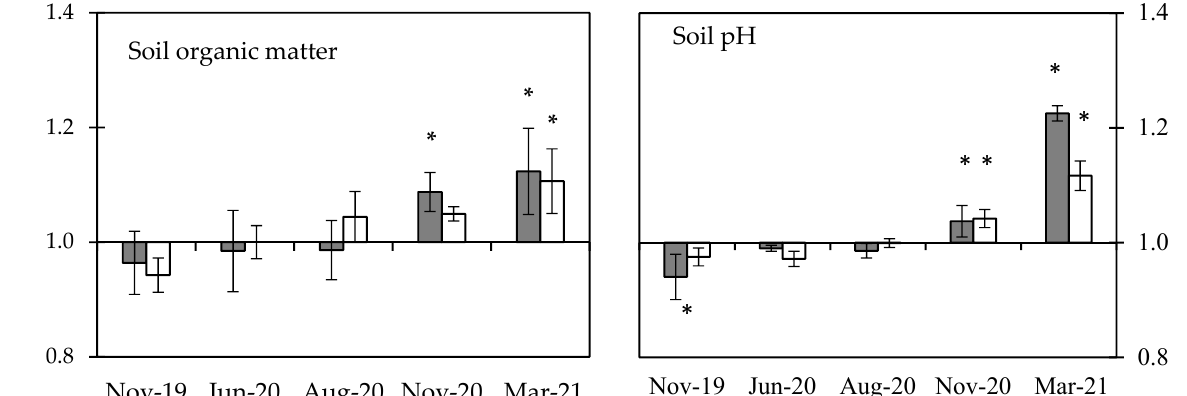
Figure 4. The effects of biochar on the soil characteristics are displayed on the y -axis; the values represent the ratio of biochar applied and without biochar. The original data of soil characteristics are listed in Table A1. Bars represent the standard error of the mean ( n = 3), where the * symbols indicate a significant difference between the value of the biochar effect and 1.0 with the multiple comparisons of the LSD test.